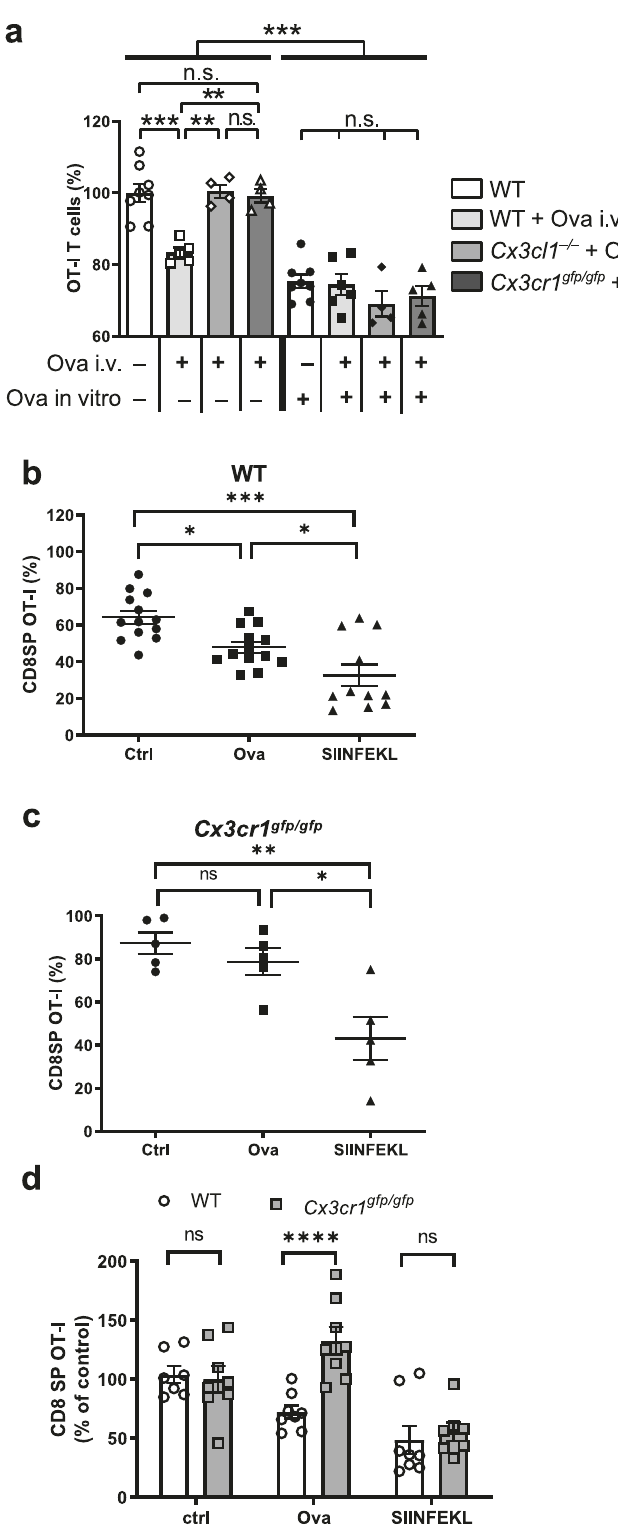
peptide in H2-k b 32 . Indeed, thymic DCs from OVA injected wild-type mice induced statistically signi fi cant thymocyte